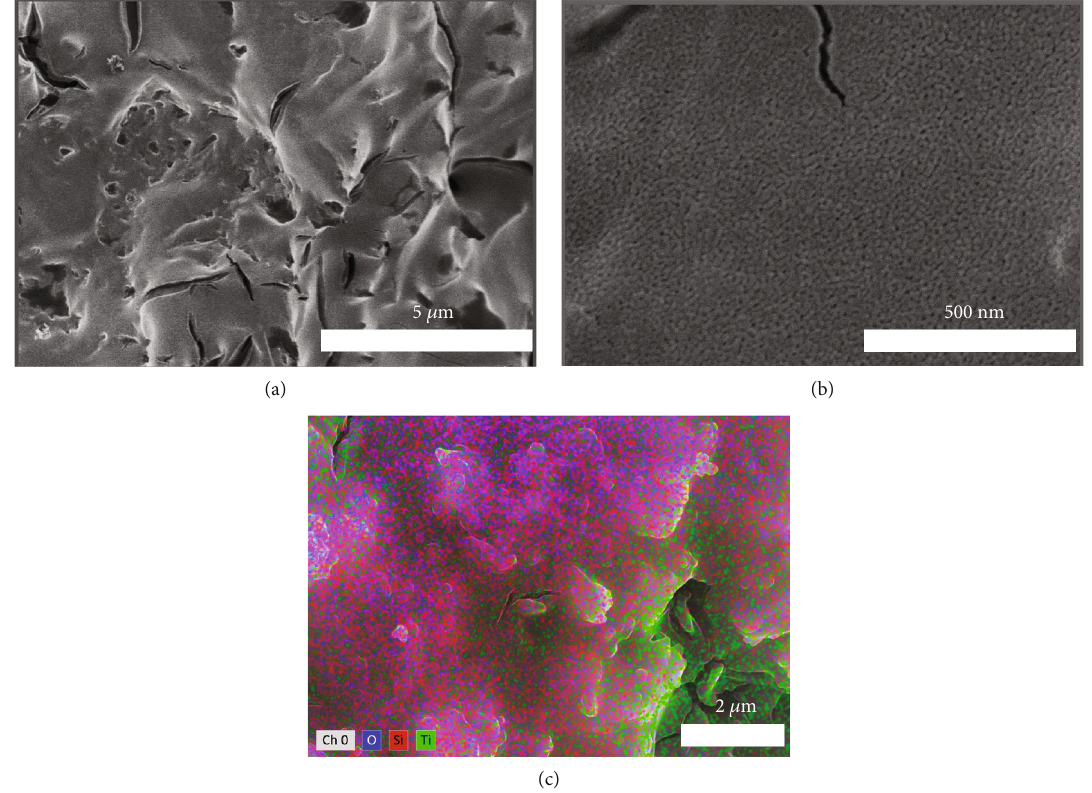
Figure 2: FE-SEM images of 15TEOS-5TiO samples at magni fi cation of (a) 10 KX and (b) 80 KX. (c) EDS element mapping 2